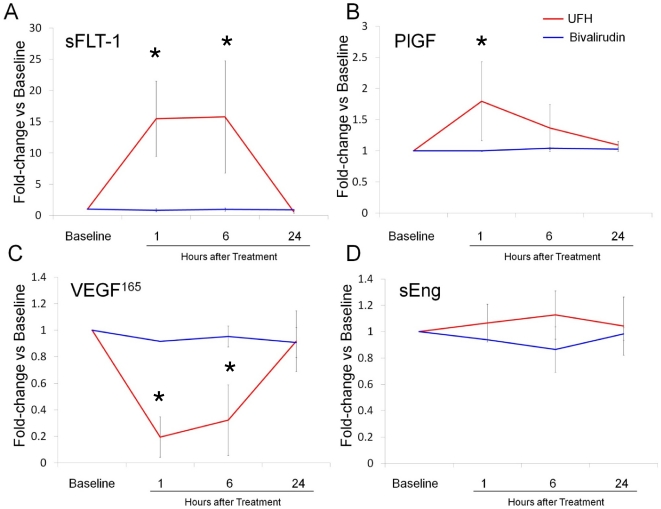
Time course of changes in sFlt1 (A), PlGF (B), VEGF165 (C) and sEng (D) with UFH and bivalirudin at baseline and 1, 6 and 24 hours after administration of anticoagulant.Note that levels of all angiogenic peptides revert to baseline levels by 24 hours with UFH and levels do not change significantly over 24 hours with bivalirudin.